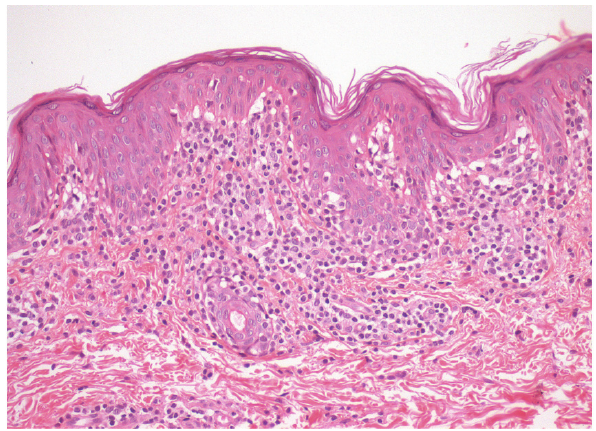
Figure 2: Dermatopathology: papillary dermal interstitial infiltrate of lymphocytes with mild atypia and